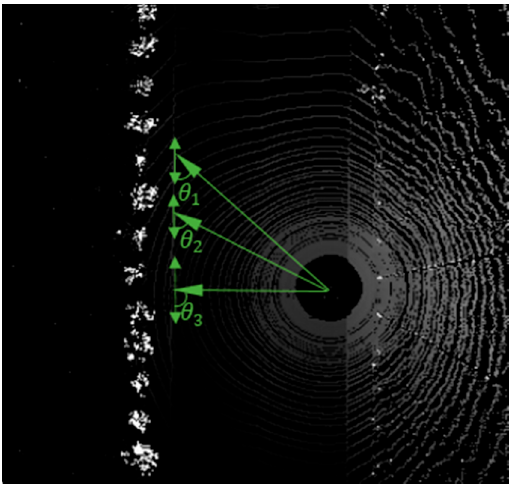
Figure 6. Schematic diagram for the variations between tangential angle and obstacle position.